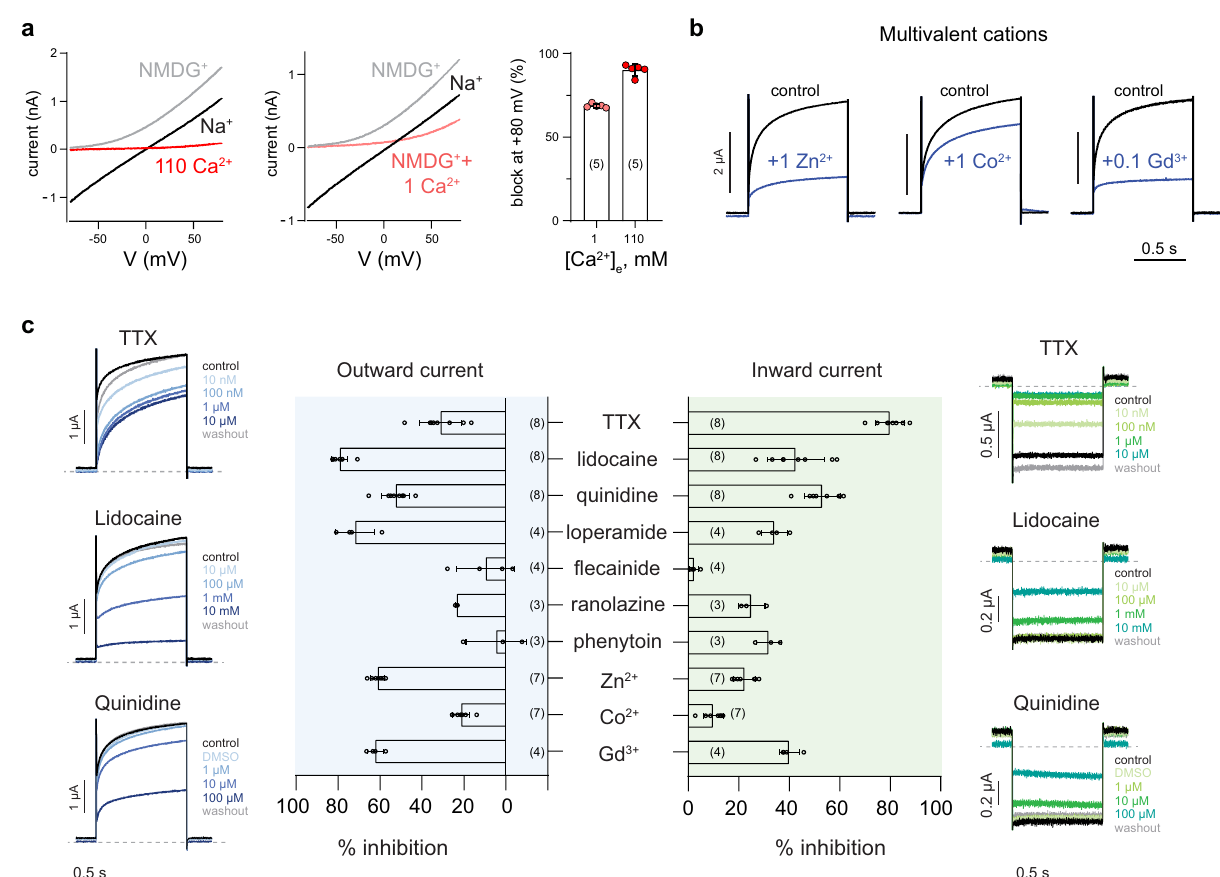
Fig. 4 Pharmacology of the human Na X -QTT channel. a Representative I – V curves from HEK293T cells expressing human Na X -QTT with indicated extracellular monovalent cations with or without indicated amounts of CaCl 2 in the extracellular solution. Voltage ramp from − 80 to + 80 mV was applied. Right, percentage of block of outward Na + by indicated concentrations of Ca 2 + at 80 mV. Data are shown as mean ± SD of n = 5 cells over three independent experiments. b Representative currents from Xenopus laevis oocytes expressing human Na X -QTT in standard extracellular solution with or without indicated divalent and trivalent cations (unit in mM), when stepping from 0 to + 80 mV. c Representative currents from oocytes expressing human Na X -QTT in standard extracellular solution with or without indicated blockers added, when stepping from 0 to + 80 mV (left) or from 0 to − 100 mV (right). Middle, summary of currents measured from two independent experiments. Data are shown as mean ± SD. Numbers of biological replicates ( n ) are indicated. See Methods for concentrations of compounds tested. Methods Protein expression and puri fi cation . Full-length human Na X containing tan- dem 2xStrepII and 2xFLAG tags at its N-terminus and untagged full-length human β 3 were each cloned into a pRK vector behind a CMV promotor. Constructs were co-transfected with PEI into Expi293 cells and cultured for 48 h in SMM 293T-I medium under 5% CO 2 at 37 °C. Cells were harvested by centrifugation at 800 × g for 10 min and resuspended and lysed in Buffer A (25 mM ADA pH 6.0, 200 mM NaCl, 1 mM PMSF, 1 μ g/mL benzonase, and 1× Roche protease inhibitor cocktail) by dounce homogenization. To solubilize the cell membranes, glyco-diosgenin (GDN) and cholesterol hemisuccinate (CHS) were added to the sample to fi nal concentrations of 2% and 0.3%, respectively, and the sample was gently stirred at 4 °C for two hours. Insoluble material was then collected by ultracentrifugation at 125,000 × g for 1 h at 4 °C. Supernatants were applied to anti-FLAG M2 agarose resin that had been pre- equilibrated in Buffer B (25 mM ADA pH 6.0, 200 mM NaCl, 0.01% GDN) and bound in batch at 4 °C for 1 h. The sample was then applied to a gravity column and the collected resin was washed with 10 CV Buffer B followed by 10 CV supplemented with 5 mM ATP and 10 mM MgCl 2 . Protein was eluted with 5 CV Buffer B supplemented with 300 μ g/mL FLAG peptide. Eluates were applied directly to Strep-Tactin XT Super fl ow high capacity resin that had been pre-equilibrated in Buffer B and bound in batch for three hours, then washed with 10 CV Buffer B prior to sample elution in 5 CV supplemented with 50 mM biotin. For nanodisc incorporation, the sample was concentrated to 15 μ M using an Amicon Ultra centrifugal fi lter device (100 kDa MWCO). For struc- tural analysis in detergent (GDN), the eluate was instead concentrated to 100 μ L and applied to a Superose 6 3.2/300 column that had been pre- equilibrated in Buffer B.